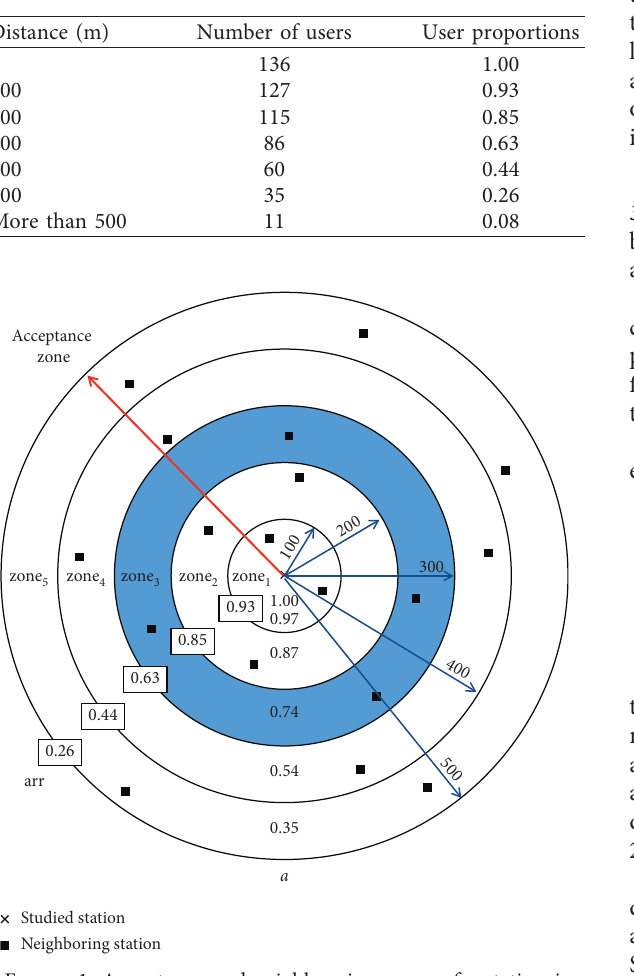
Table 1: Survey results concerning the distance users are willing to walk.